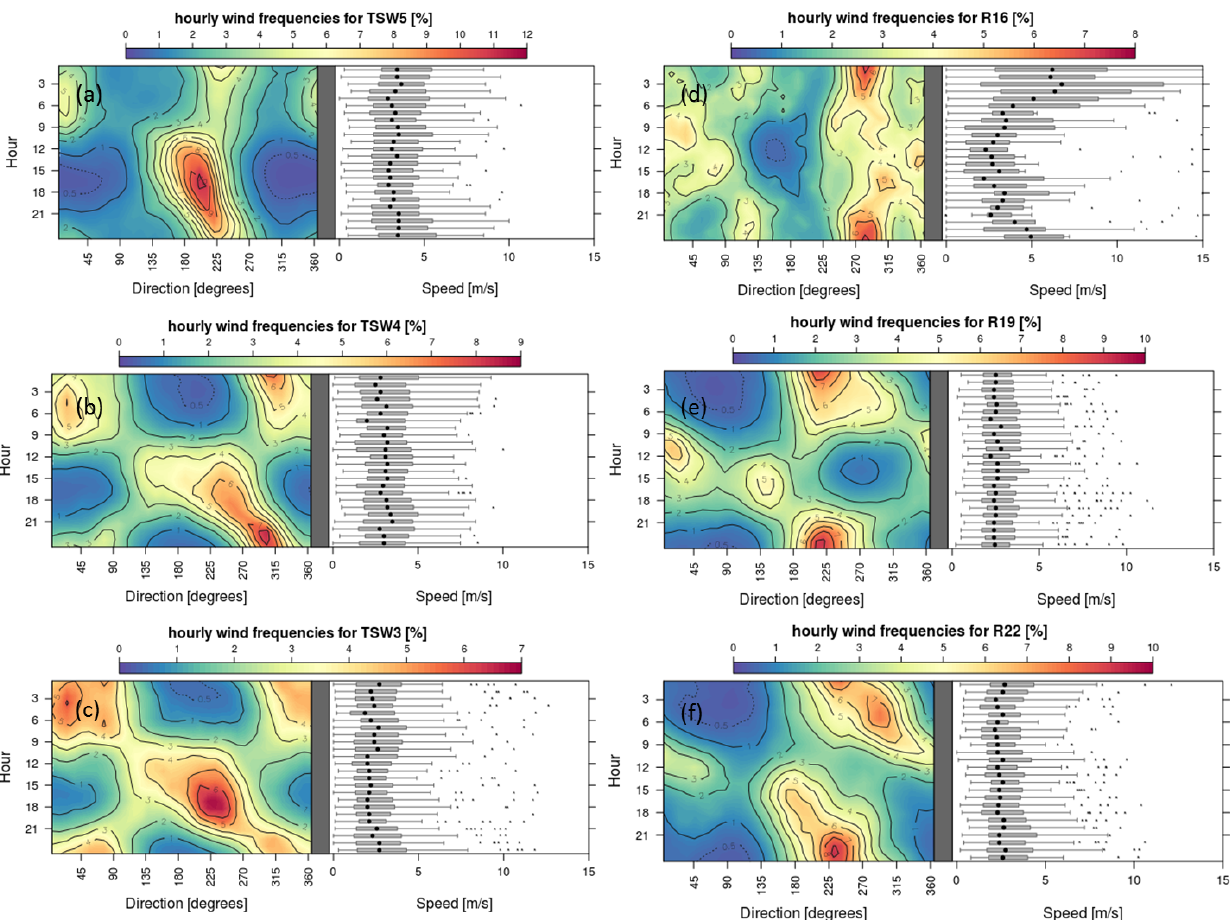
Figure 8. Contour plots of hourly wind frequencies and corresponding wind speeds for a transect on the southwestern slope of Big Southern Butte (a–c) and a transect on the northeastern slope of Big Southern Butte (d–f) . Panels are ordered from higher-elevation sensors (a, d) to lower-elevation sensors (c, f) . Periods of synoptic forcing were removed from these